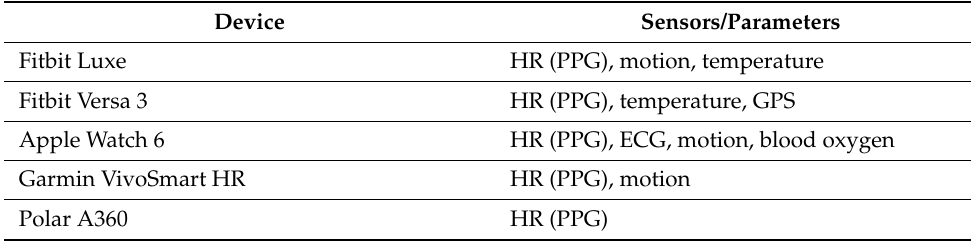
Table 5. Examples of wearable consumer grade wrist cardiac monitors.